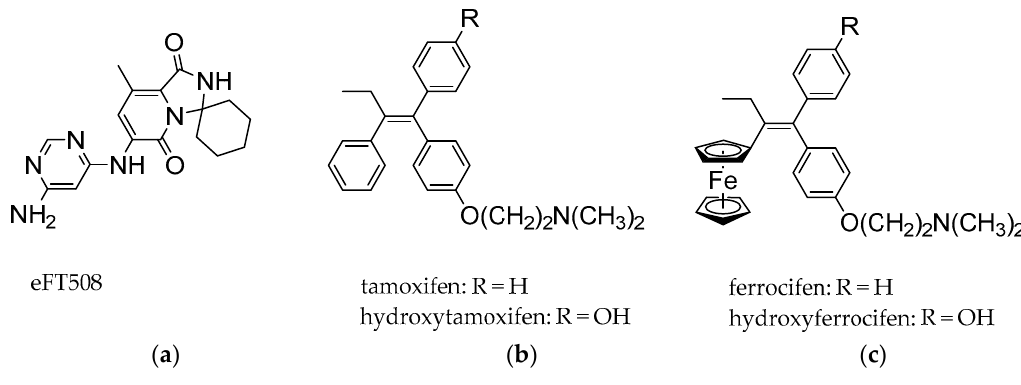
Figure 1. Chemical structures. ( a ) Structure of eFT508, a MNK1/2 inhibitor, ( b , c ) structures of prodrugs and hydroxylated drugs; tamoxifen and ferrocifen.